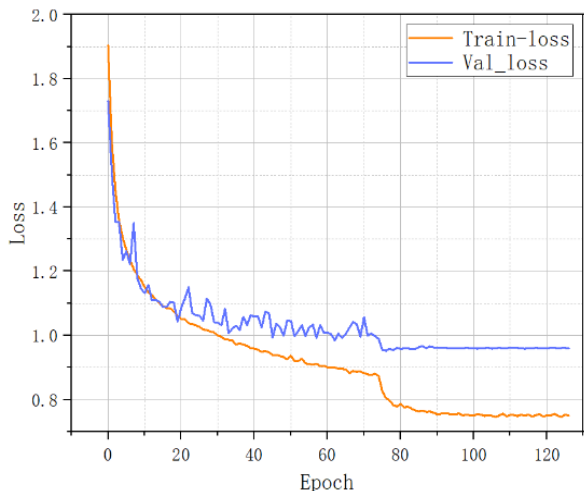
Figure 14. Loss function curve.